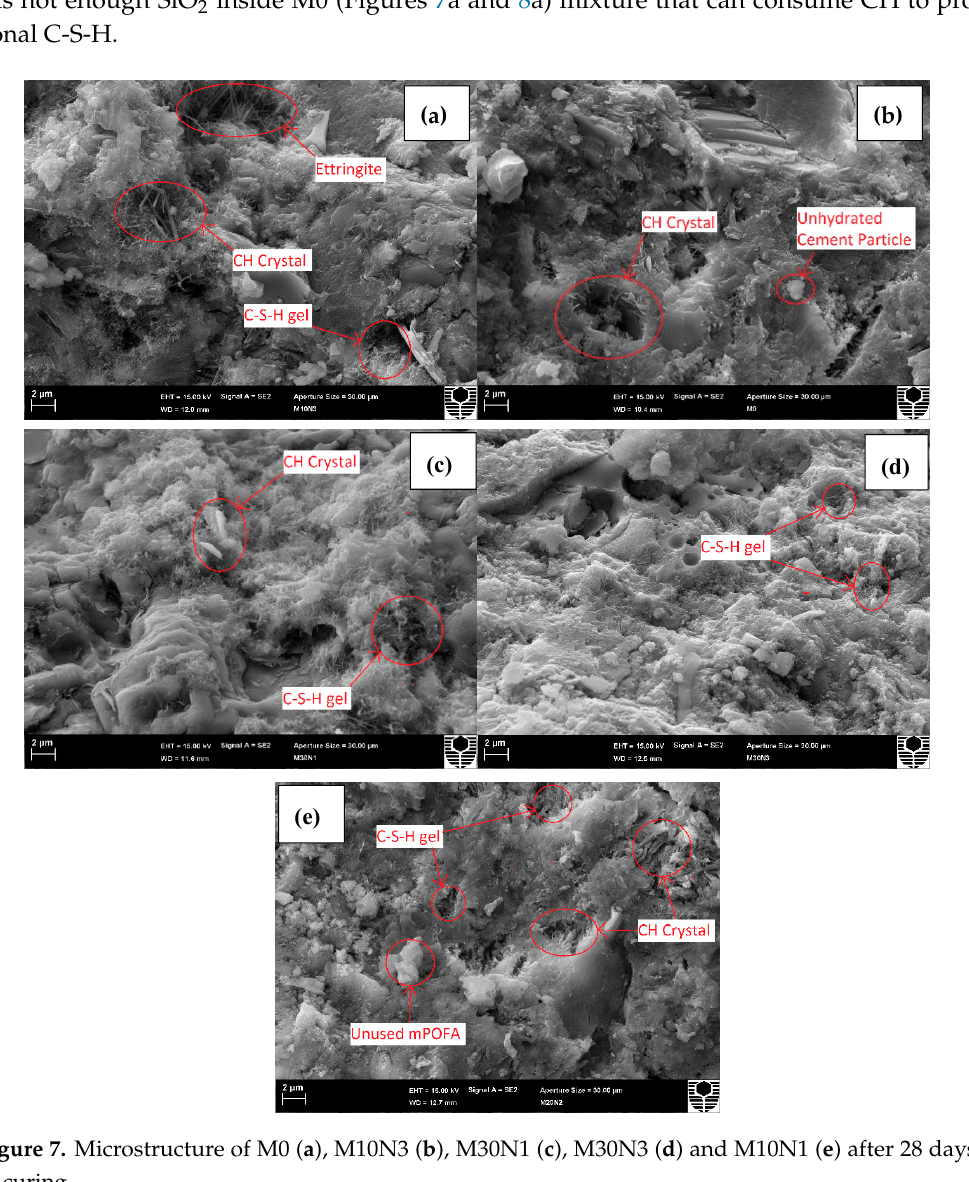
Figure 7. Microstructure of M0 ( a ), M10N3 ( b ), M30N1 ( c ), M30N3 ( d ) and M10N1 ( e ) after 28 days of curing.